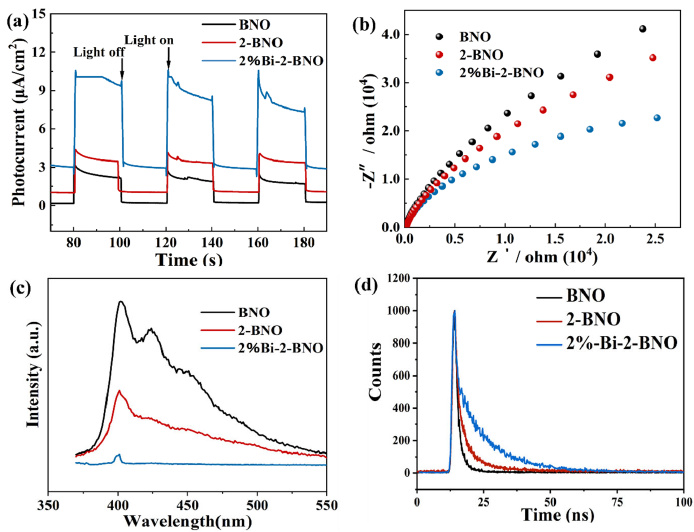
Figure 9. ( a ) Transient photocurrent responses; ( b ) EIS spectra of the as ‐ prepared samples; ( c ) pho ‐ toluminescence spectra; ( d ) time ‐ resolved photoluminescence spectra of the